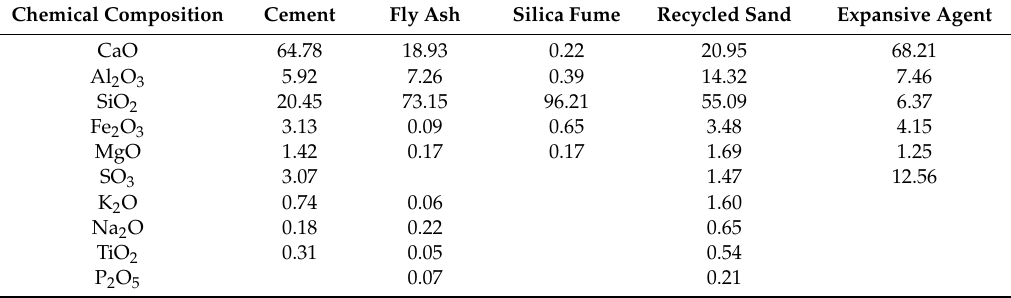
Table 1. The chemical compositions of cement, fly ash, silica fume, recycled sand, and expansive agent